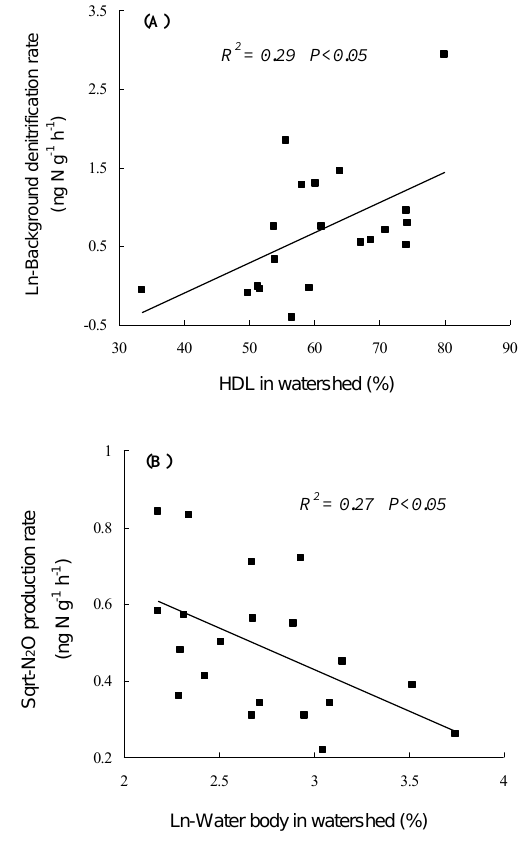
Figure 3. Relationships between human-dominated land uses ‐ (HDL) in watershed and sediment background denitrification rate (a) and between water body in watershed and N 2 O production rate (b) of the Yangtze lakes ( N =